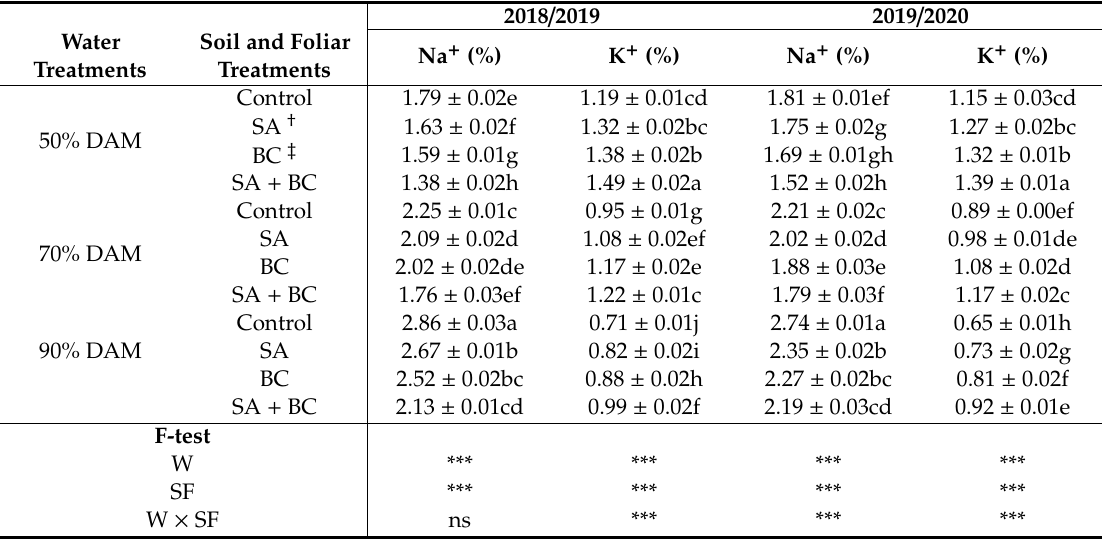
Table 2. The percent of Na + and K + in the leaves of wheat plants irrigated with (50%, 70%, and 90% DAM) in saline sodic soil treated by salicylic acid and biochar during two growing